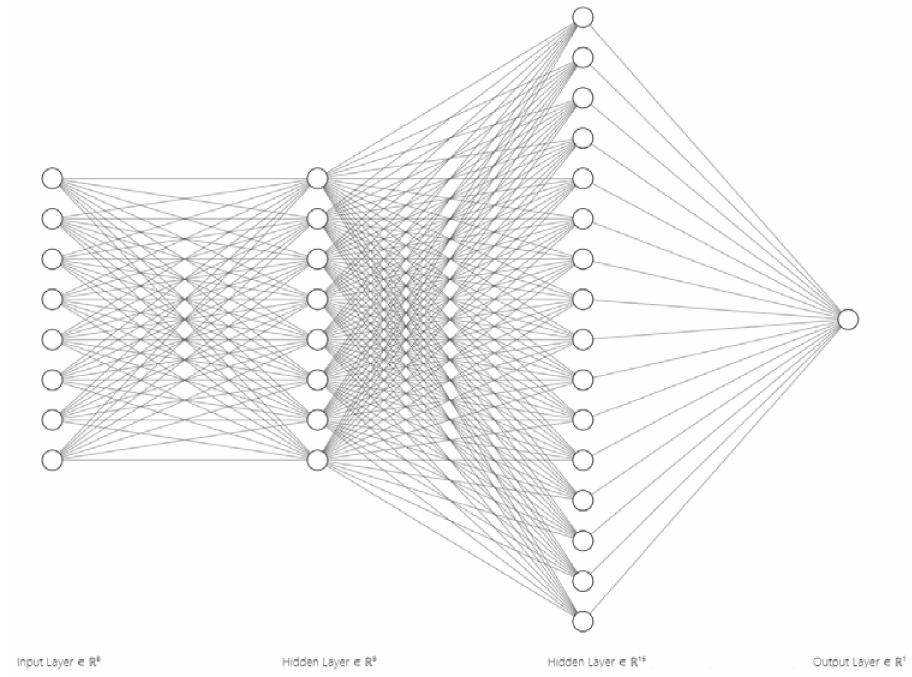
Figure 3. Neural network architecture schematics.